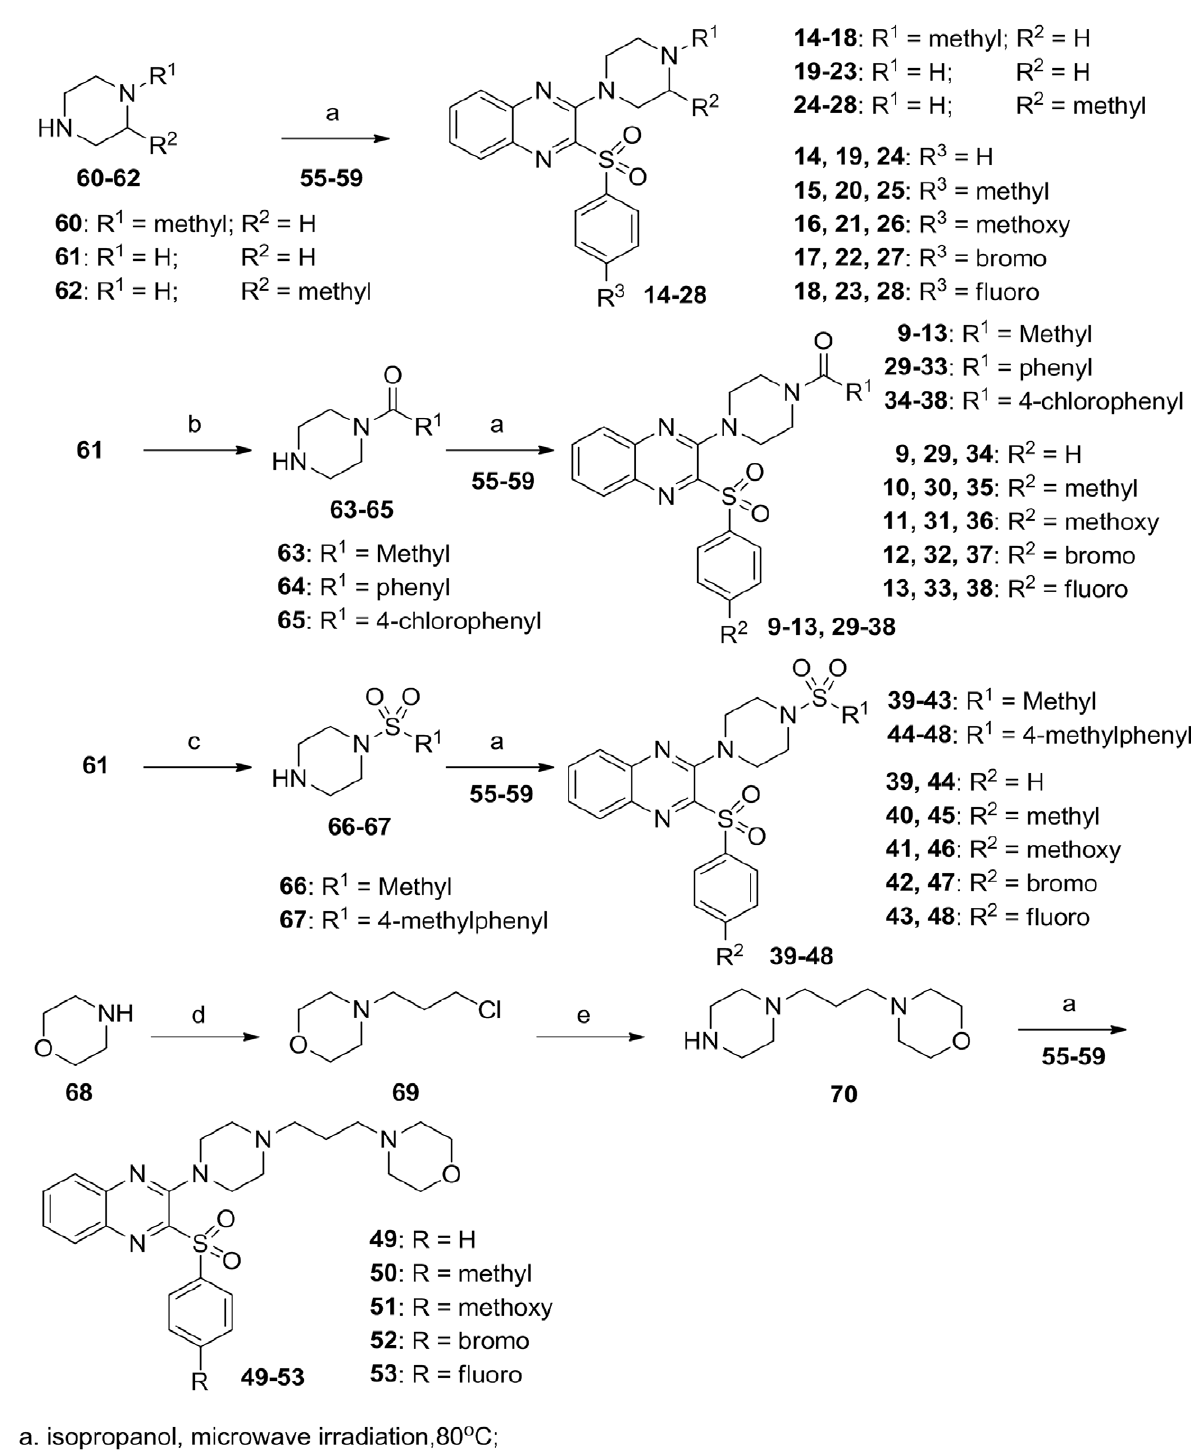
Figure 4. Synthesis of piperazinylquinoxalines 9–53.